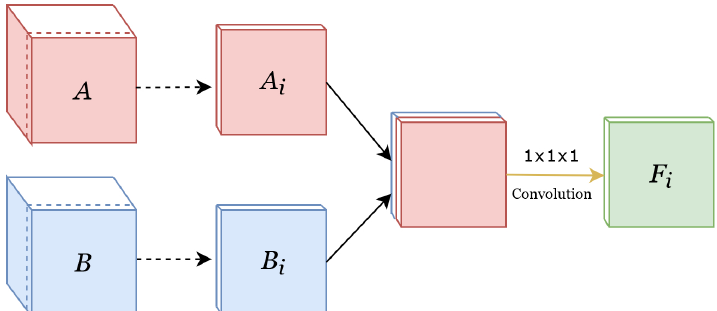
Figure 3. Implementation of the weighted-sum feature fusion. Since it is not possible to depict the original 4D structure, the features are depicted in 3D. A and B are the feature sets of the first and second modalities, respectively. The dotted arrows show the separation of the i -th channel from both the red and the blue feature-set, where A i and B i are the i -th channel of A and B. A convolutional operator is then used to combine these two channels into one channel, depicted as F i